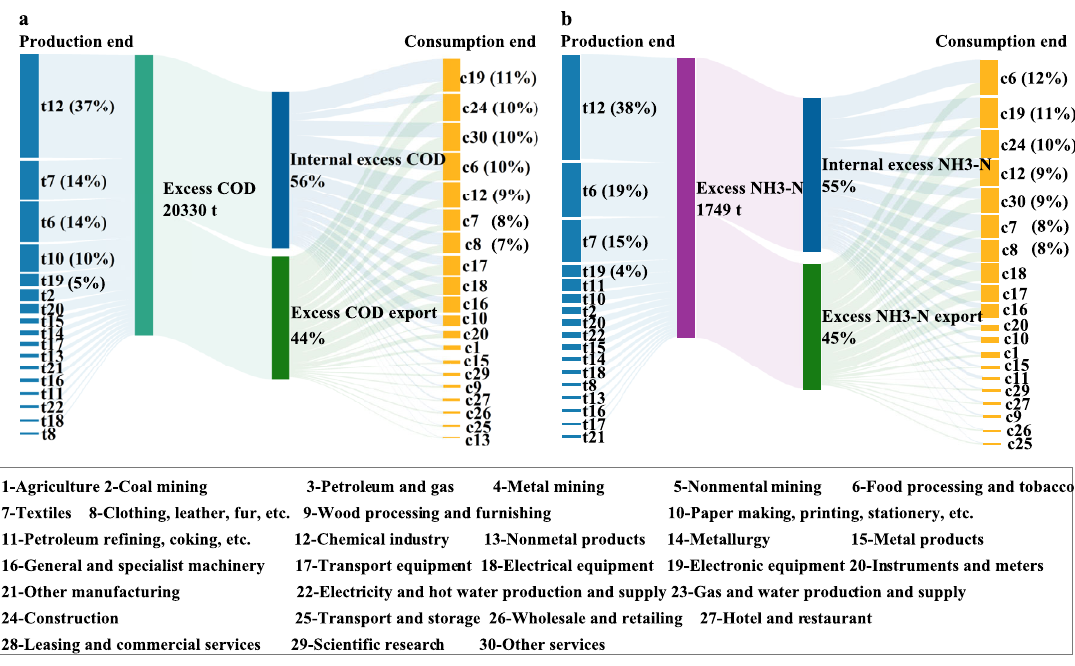
Fig. 2 Inter-sector fl ows of excess pollution discharge from the production end in Jiangsu Province to the consumption end in Jiangsu and other Chinese provinces. a excess COD and b excess NH 3 -N. Sectors with excess COD (from both production and consumption) of <100 tons/yr and sectors with an excess NH 3 -N of <10 tons/yr are not shown in this fi gure. The list of 30 Chinese provinces is shown in Supplementary Table